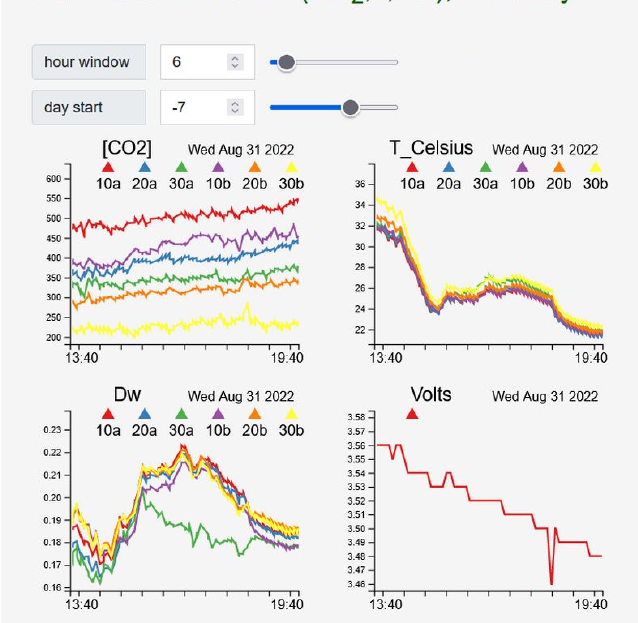
Figure 10. ETR device behaviour in open-air on the app